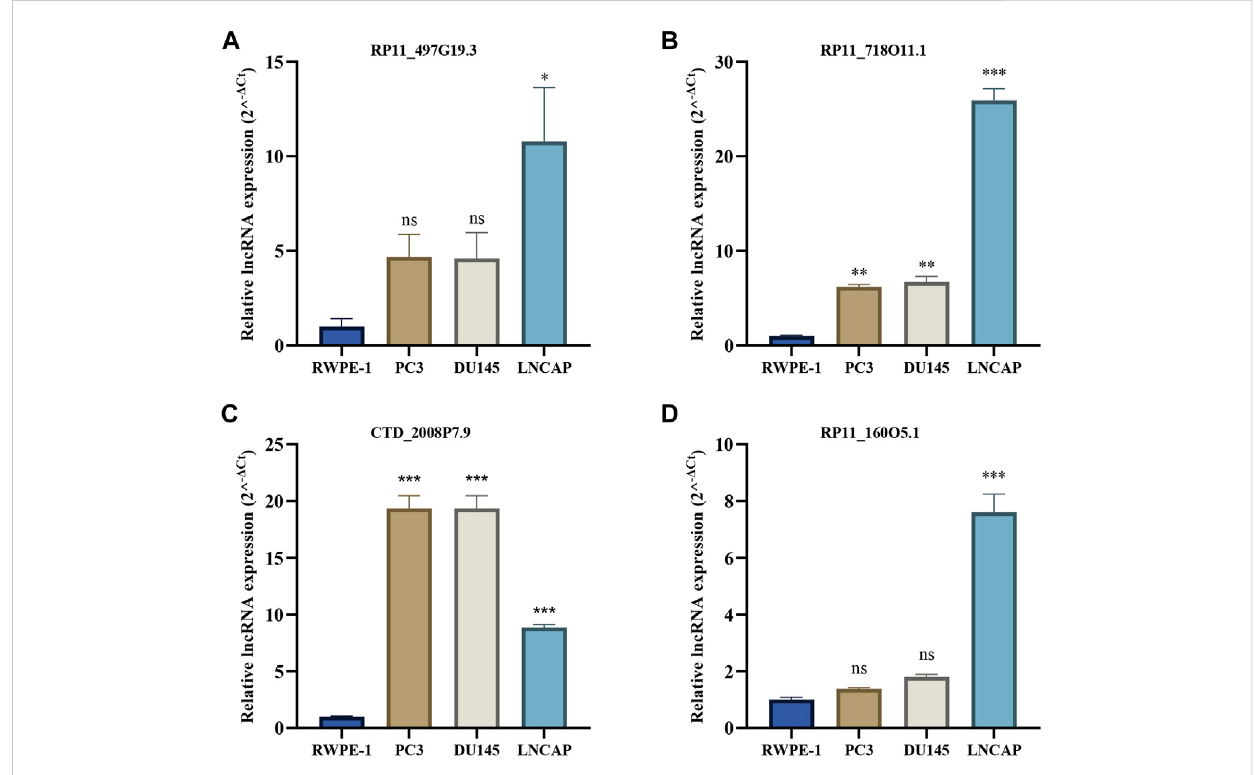
FIGURE 11 The qRT-PCR results of four crlncRNAs in three PCa cell lines. (A) qRT-PCR result of RP11-497G19.3. (B) qRT-PCR result of RP11O-718O11.1. (C) qRT-PCR result of CTD-2008P7.9. (D) qRT-PCR result of